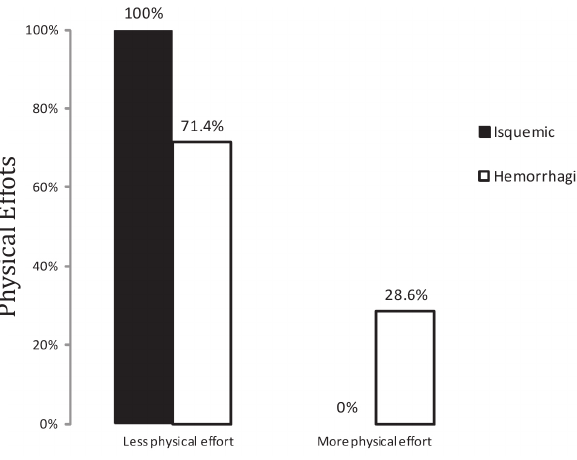
Figure 3 - Relationship between type of stroke and physical effort required to play the game.